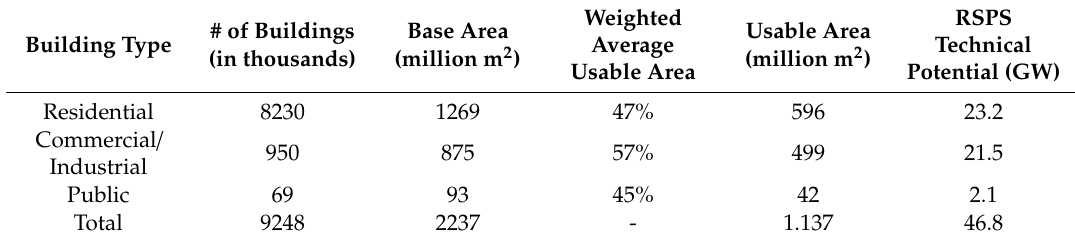
Table 3. According to Rooftop Solar Market Assessment Summary Note Data from [23], the Potential of The Rooftop Solar Photovoltaic System (RSPS) in